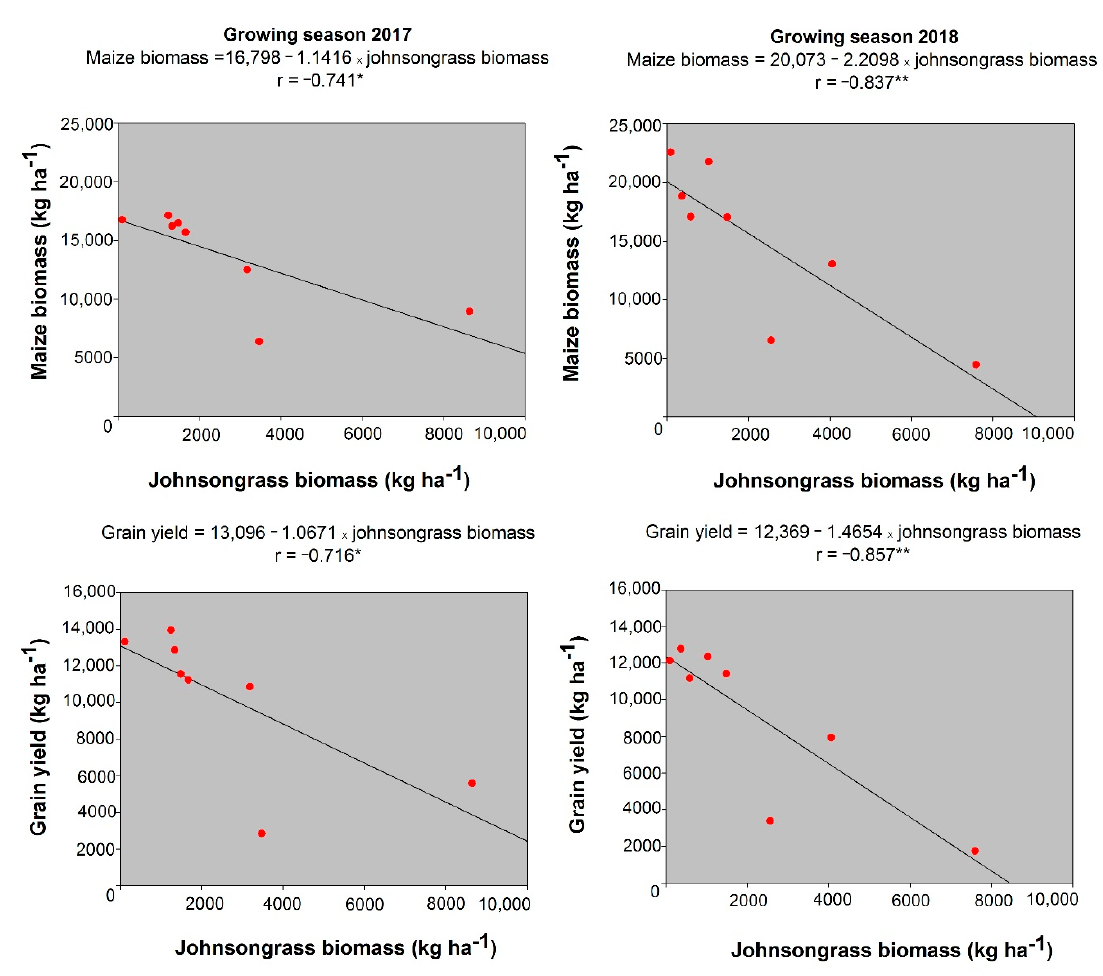
Figure 7. Pearson correlation coefficients between the main maize parameters (aboveground biomass and grain yield) and johnsongrass aboveground biomass. r was calculated using the linear equation ( n = 8), * significant at p < 0.05 and ** significant at p < 0.01.